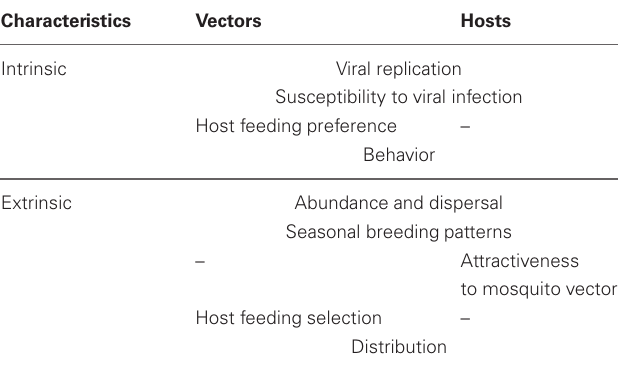
Table 1 | Intrinsic and extrinsic characteristics fulfilled by a vector/ host of an arbovirus.